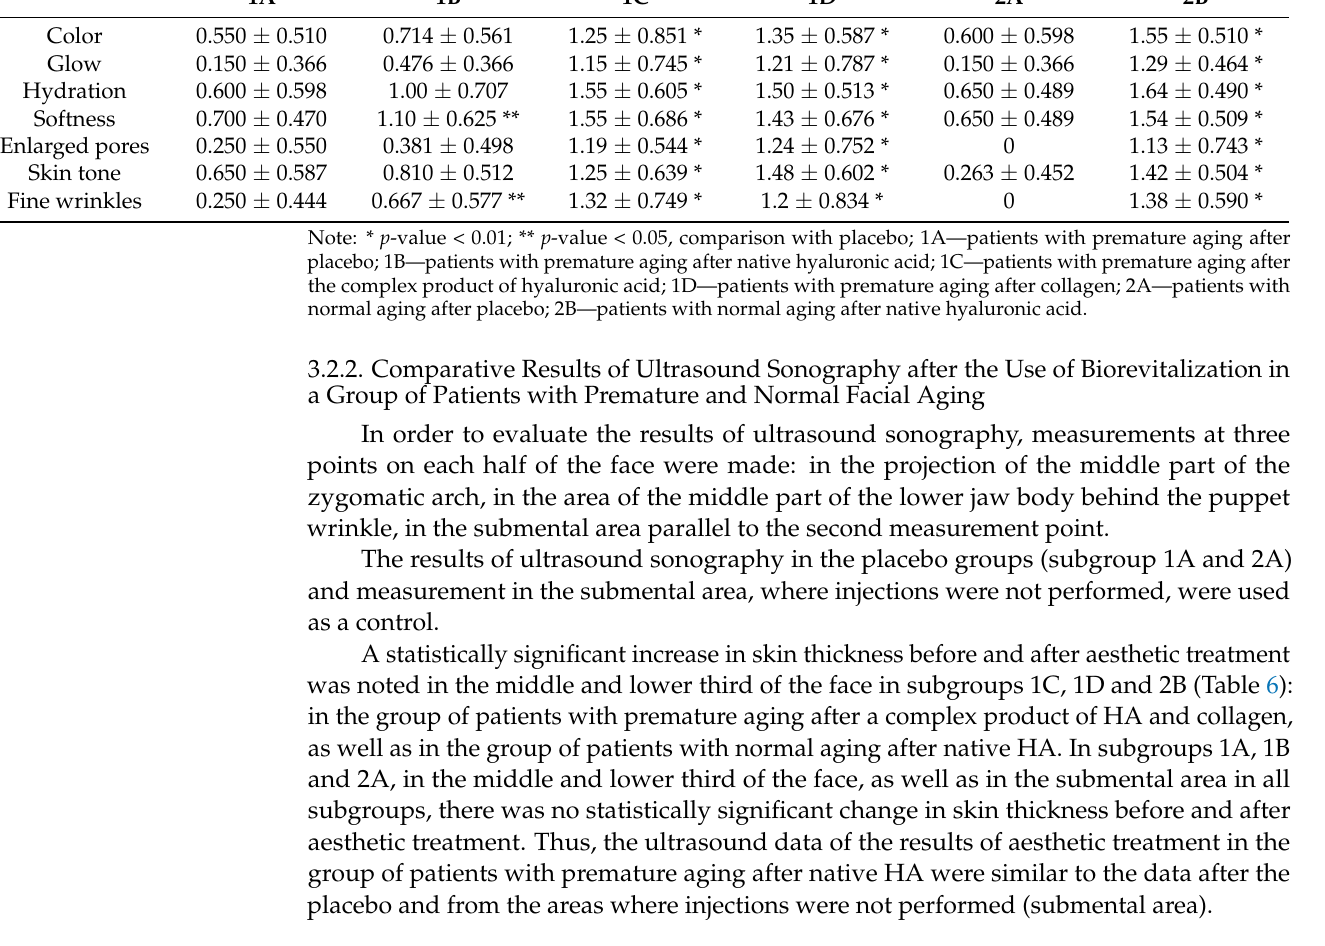
Table 6. Ultrasound sonography results in the main group of patients before and after aesthetic treatment (M ±